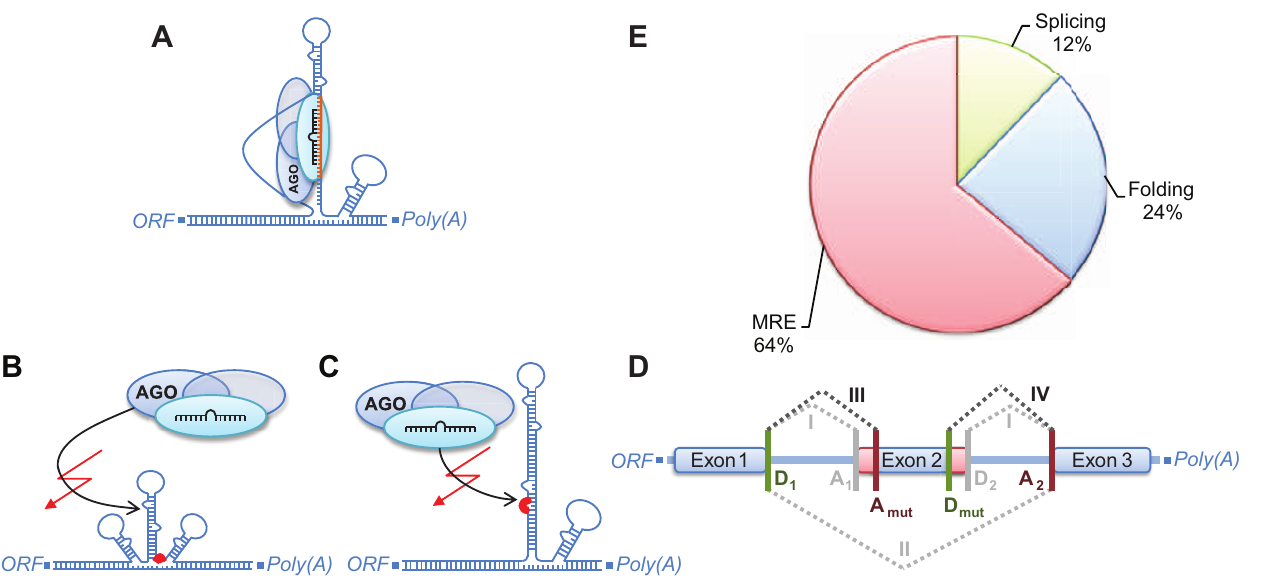
Figure 2. Mechanisms mediated by 3 9 -UTR SNPs affecting miRNA targeting. A: Regular binding of the RISC to the target mRNA. B: Binding of the RISC and, thus, miRNA-mediated silencing is inhibited by a change in RNA secondary structure. C: A mutation within the MRE seed site disrupts the ability of a certain miRNA to target a transcript. Here, the opposite effect also applies, i.e. a new MRE seed site is formed by a polymorphism which enables targeting by a miRNA usually not controlling the respective transcript. D: Altered splicing by acceptor or donor splice site gain. The existing splice variants (I and II, grayed) are extended by mutationally introduced additional splice variants: (III) A present acceptor site (A 1 ) is substituted by a new acceptor site (A mut ), and (IV) a naturally occurring donor site (D 2 ) is replaced by a new donor site (D mut ). Both effects may lead to a considerable loss of exon sequence (displayed in red) and, thus, RISC binding sites. E: The percentages of classified SNPs mediating the single mechanisms. The greatest amount of functionally annotated 3 9 -UTR SNPs directly affect MRE sequences, followed by SNPs changing the RNA secondary structure and SNPs with an predicted effect on 3 9 -UTR splicing.